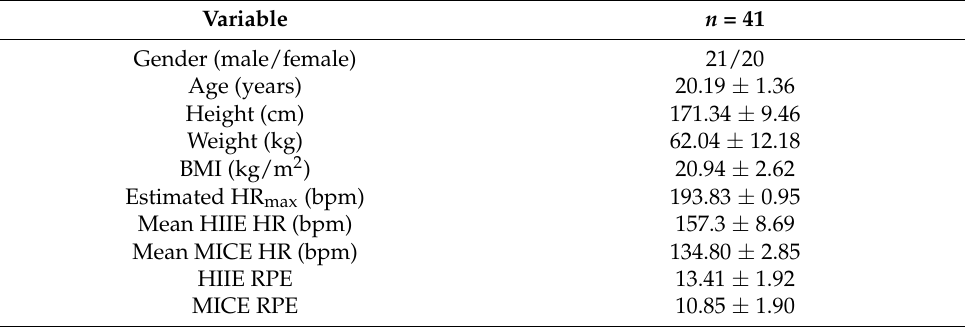
Table 1. Demographic characteristics data ( M ± SD